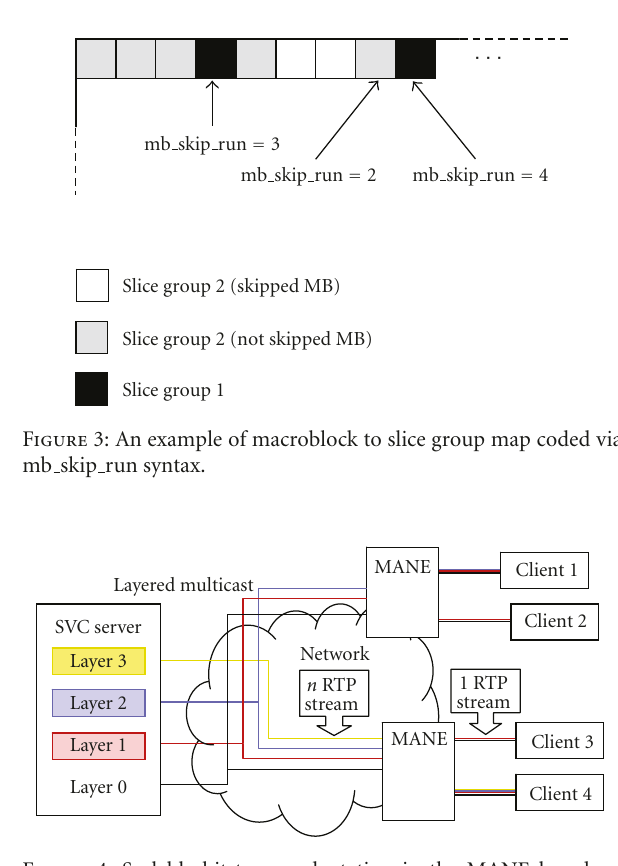
Figure 4: Scalable bitstream adaptation in the MANE based on users